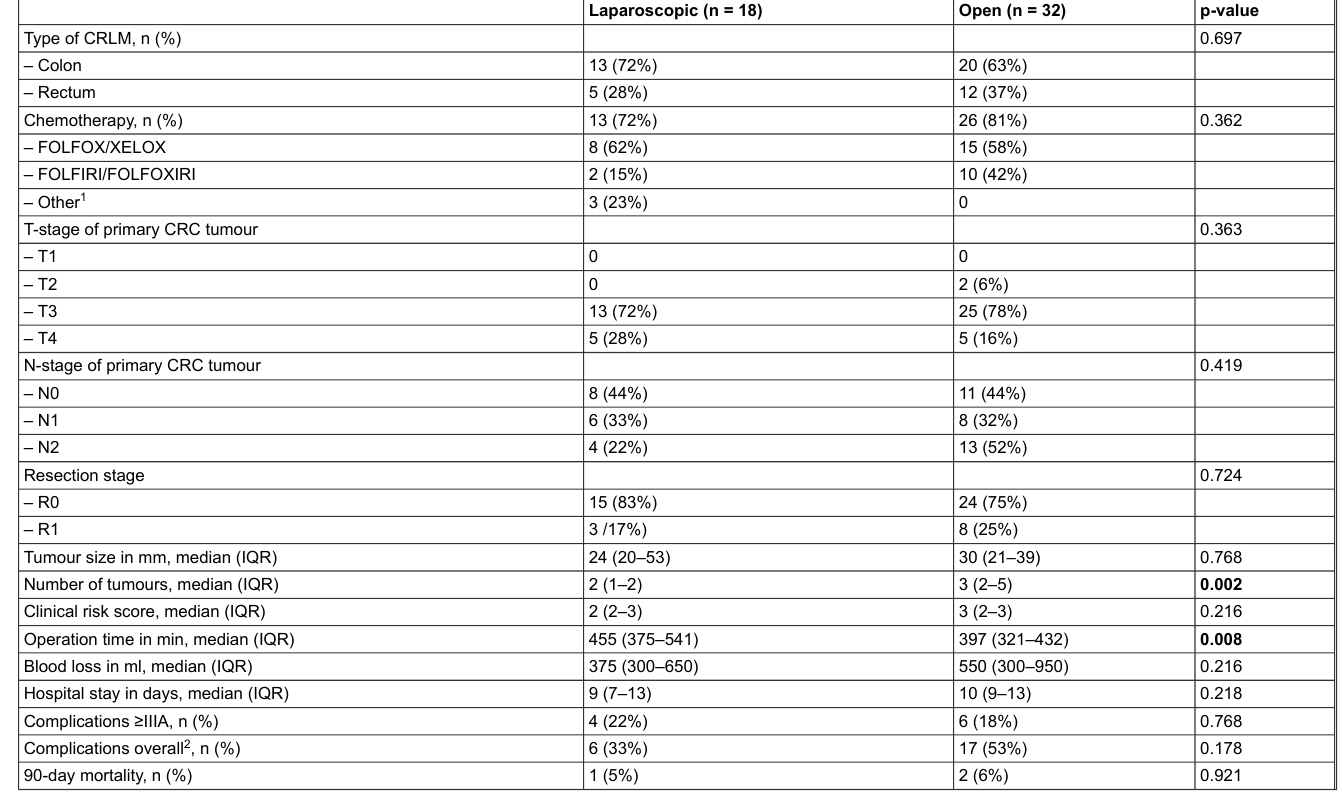
Table S1: Clinical outcome of CRLM subgroup in cantonal hospitals Winterthur and Lugano